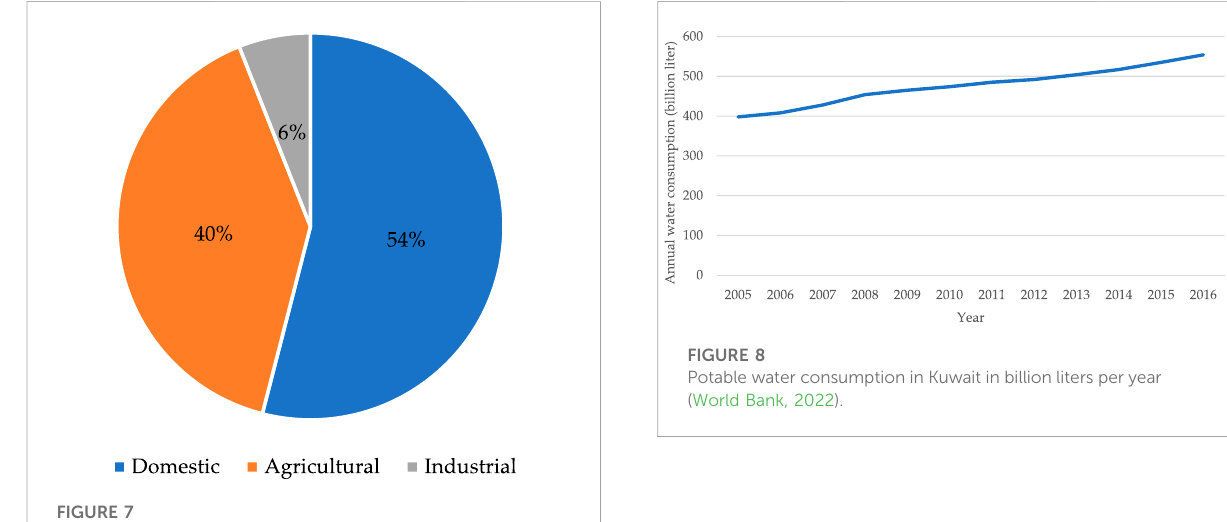
FIGURE 7 Water consumption in different sectors in Kuwait (World Bank, 2022).